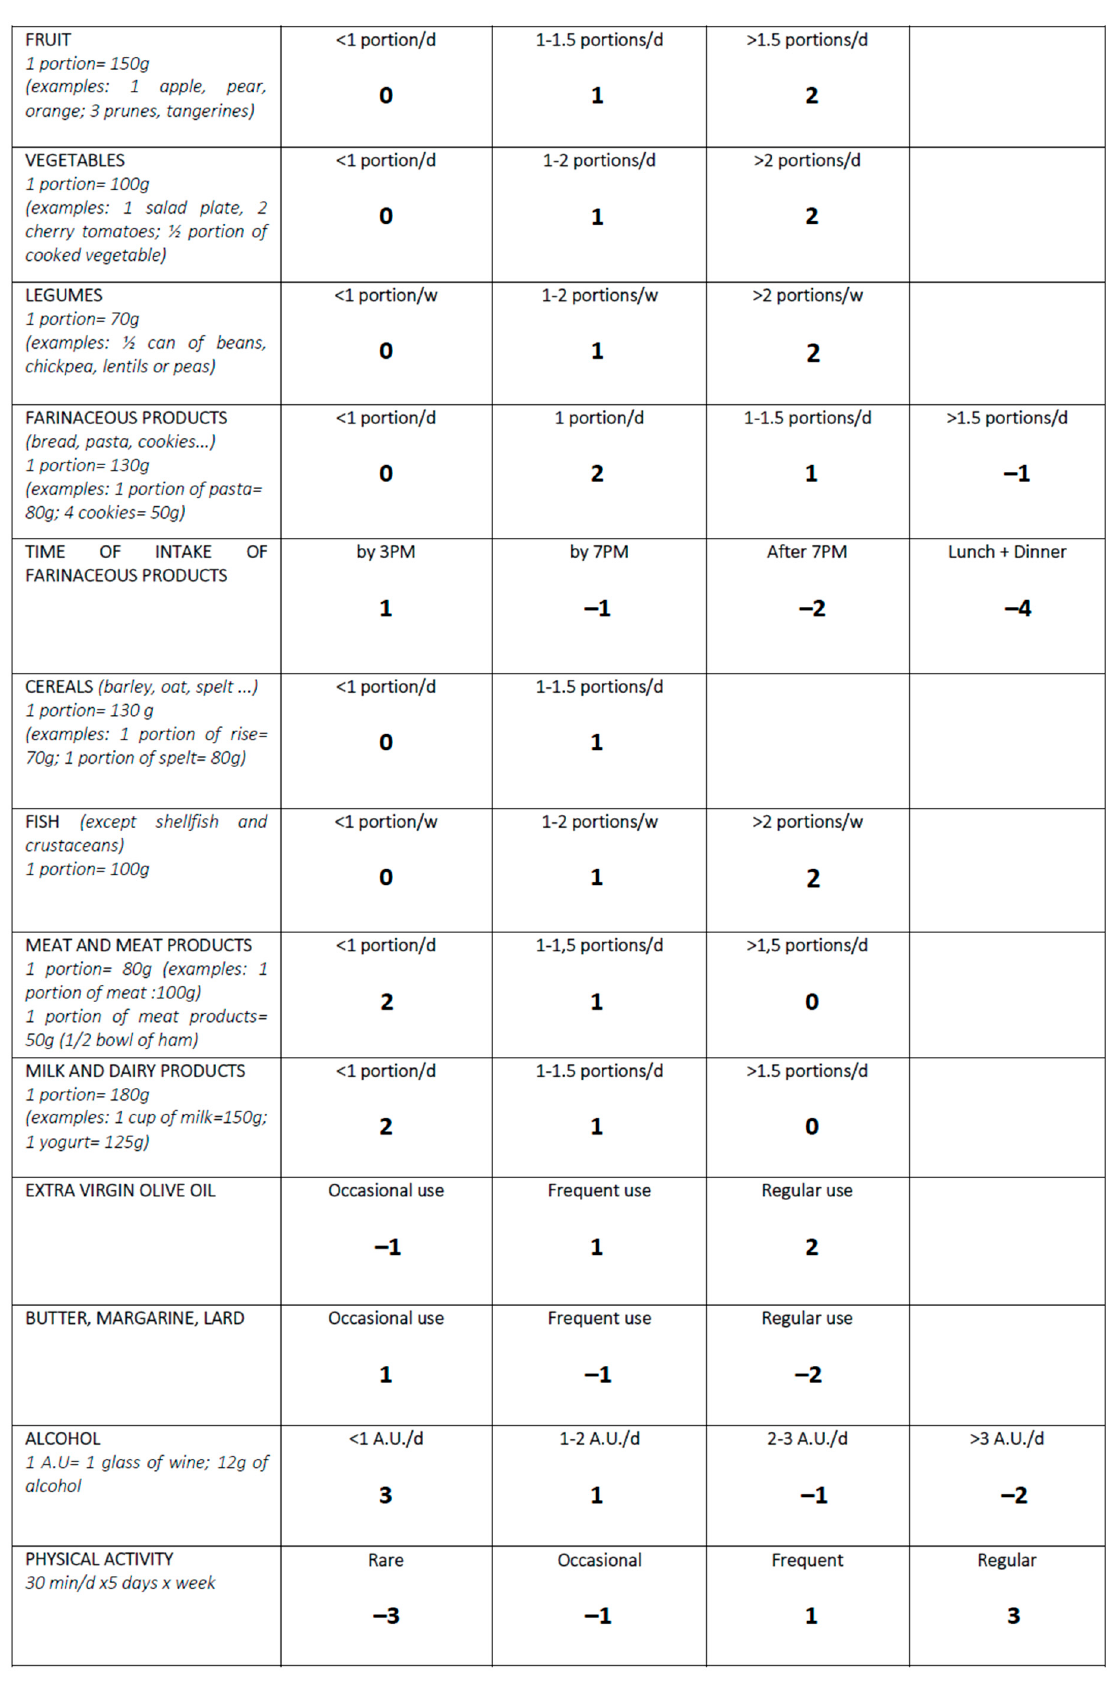
Figure 1. The Chrono Med Diet Score. Abbreviations: day, d; week, w; post meridian, PM.